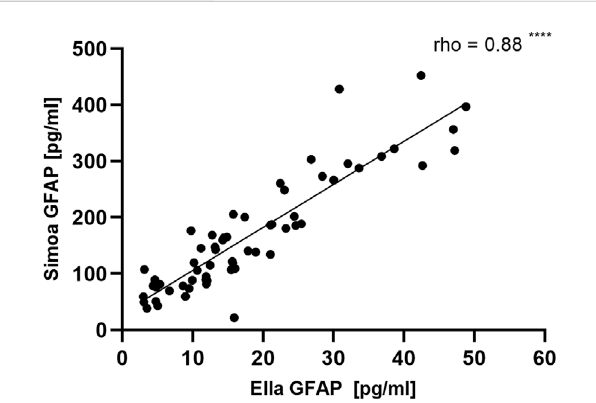
Correlation of measured GFAP values for serum samples by Ella and Simoa. 63 serum samples were analyzed with the novel Ella assay and the available Simoa GFAP discovery kit. The results correlated signi fi cantly between the two assays [ r = 0.88 (95% CI: 0.81 – 0.93), p < 0.0001]. CI, Con fi dence interval; GFAP, Glial fi brillary acidic protein; Simoa, single molecule